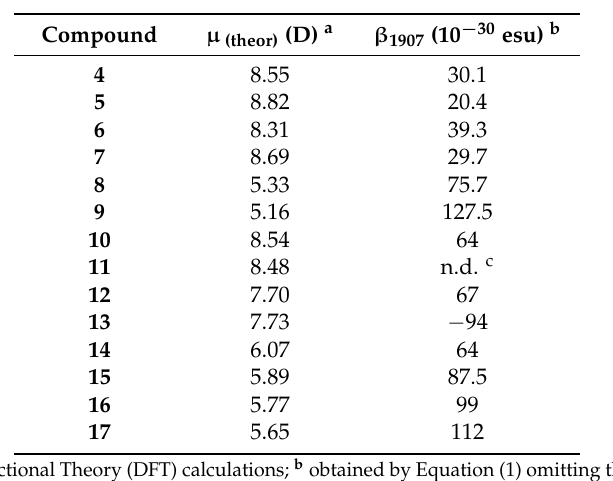
Figure 2. Asymmetrical tetraphenylporphyrins and Zn II complexes with electron donor or electron acceptor substituents in β -pyrrolic position ( a ), and asymmetrical 10,20-diphenylporphyrins and Zn II complexes with electron donor or electron acceptor substituents at the meso position ( b ). Adapted from Eur. J. Inorg. Chem. 2005 , 3857–3874 and from Eur. J. Inorg. Chem. 2006 , 1743–1757. Table 1. Theoretical dipole moments, and Electric Field Second Harmonic Generation (EFISH) β 1907 in CHCl 3 solution of chromophores 4 – 17 .